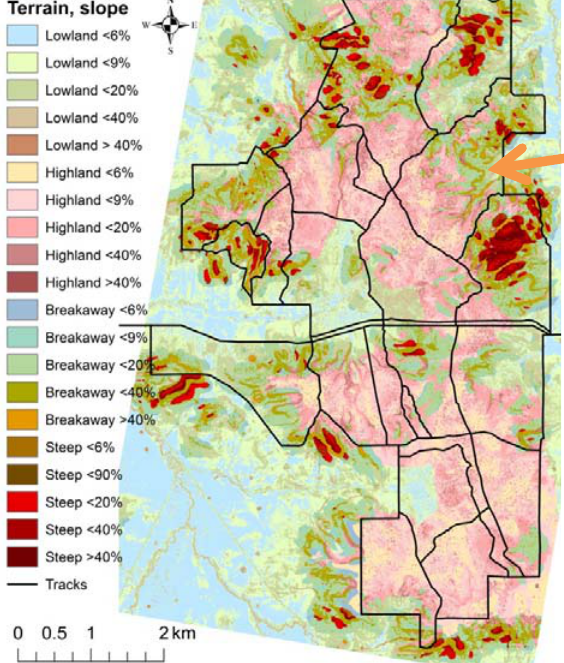
Figure 1. Geomorphological classes for the area scanned with LiDAR and tracks within the western part of Boyagin Nature Reserve. The orange arrow indicates the direction of view in Figure 2.